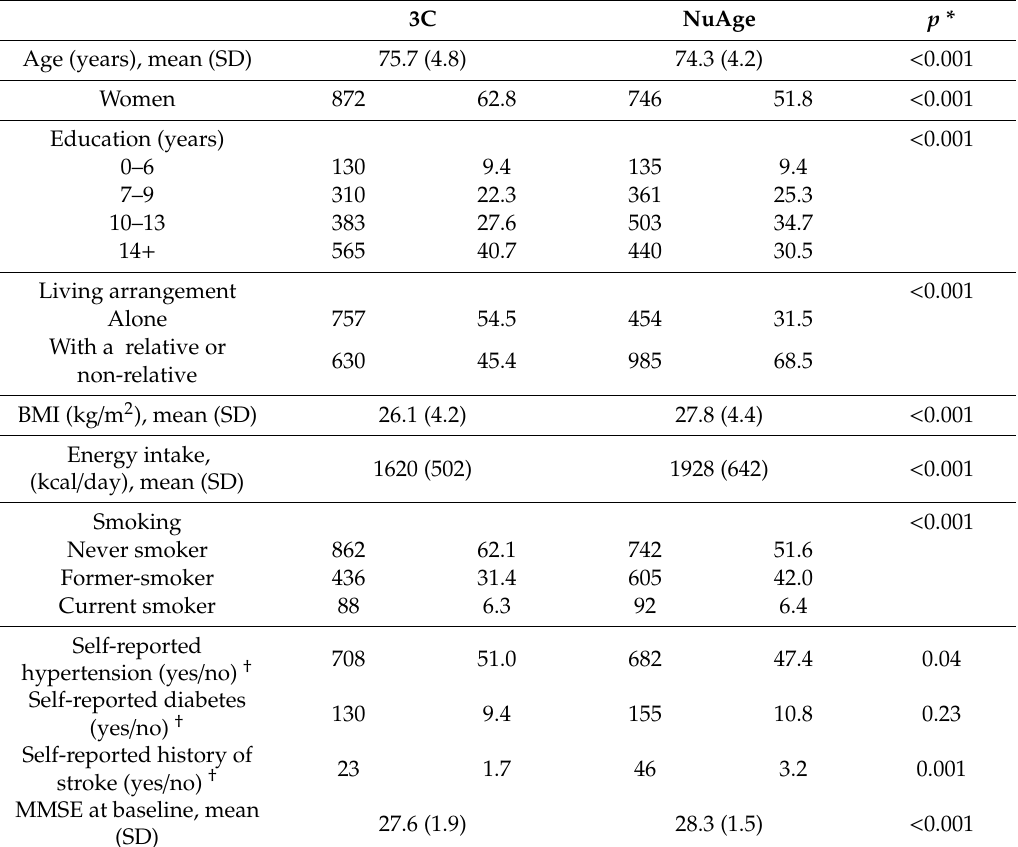
Table 1. Characteristics of participants of the 3C ( n = 1388) and the NuAge ( n = 1439) studies. 3C NuAge p